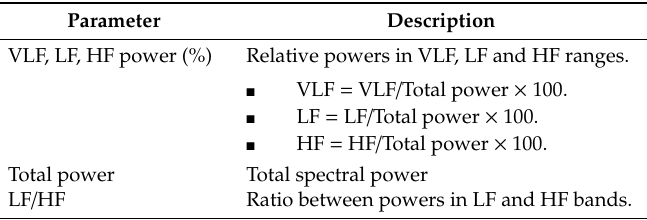
Table A2. Description of frequency-domain HRV measurements.